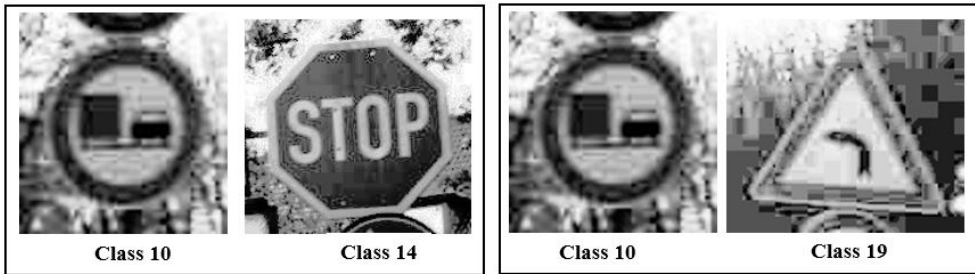
Figure 7. Confusion matrix of ensemble learning on the GTSRB dataset.